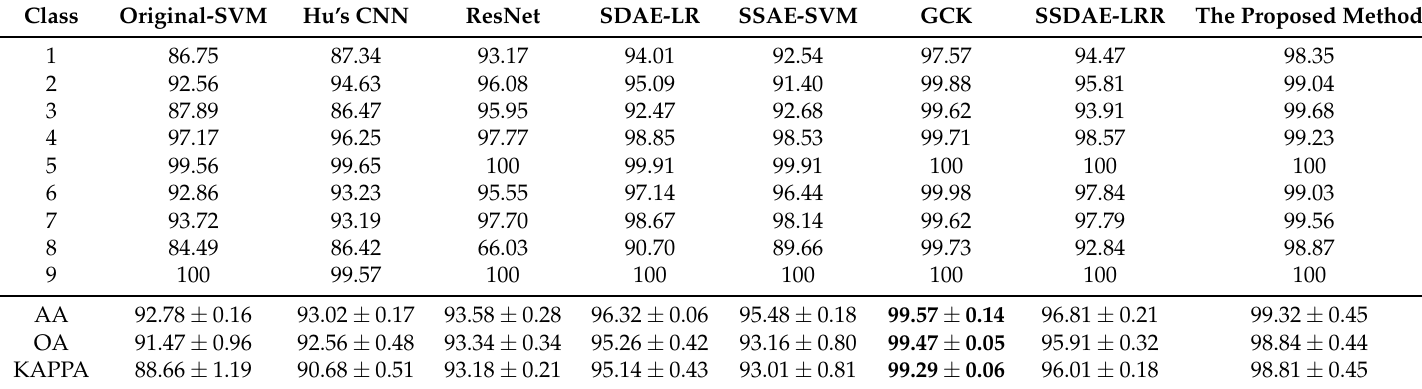
Table 3. Classification accuracy (%) of different methods on Pavia University dataset (a total of 1800 labeled samples were used for training).